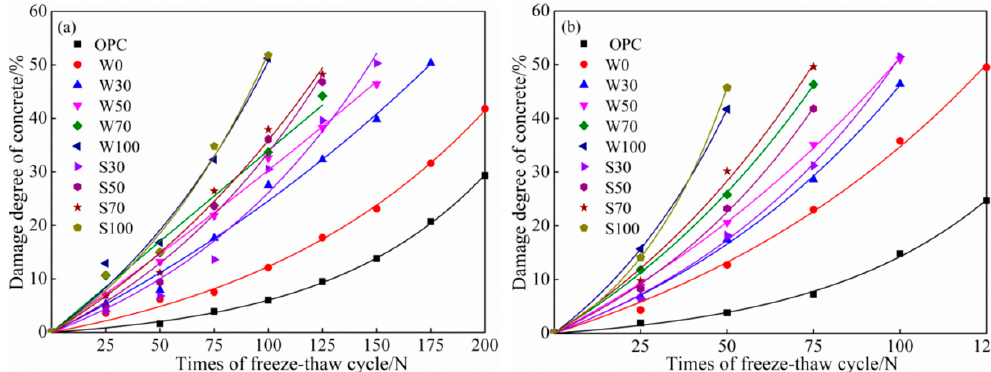
Figure 10. Accumulative freeze-thaw damage exponential function model of ( a ) water freeze-thaw cycle and ( b ) salt freeze-thaw cycle of alkali-activated coal gangue-slag concrete (ACSC).